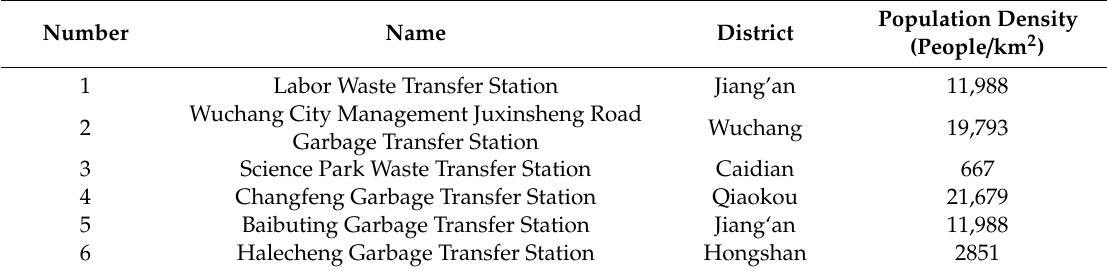
Table A3. Candidate locations for temporary transit centers.